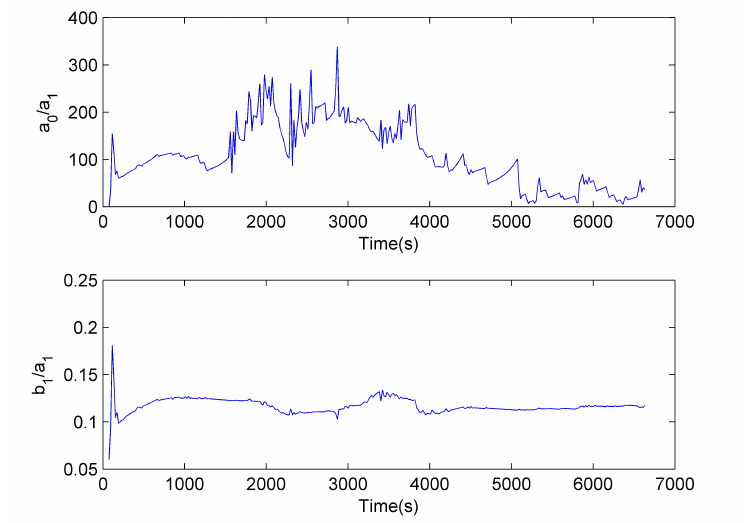
Figure 12. Experimental parameter estimation of the proposed method.